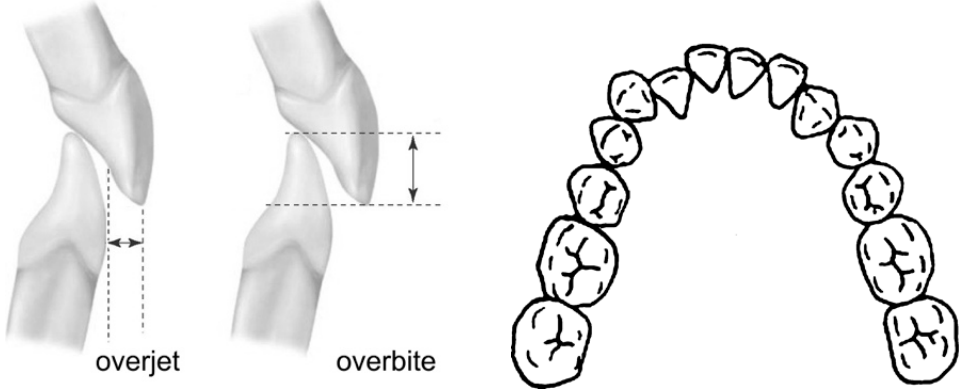
Figure 1. Overjet, overbite and crowding–spacing dental irregularities are frequently the main reasons for an orthodontic consultation.